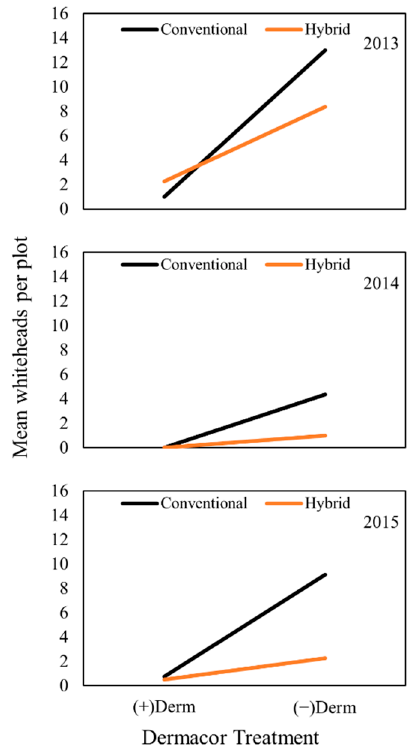
Figure A1. Interactive effects of Dermacor treatment and variety on L. oryzophilus larval densities in 2013, 2014, and 2015. Core 1 ( A , B, and C ) and Core 2 ( D , E, and F ) sampling were performed three and four weeks after permanent flooding. Parallel lines indicate absence of interaction ( P > 0.05), while lines with different slopes (non-parallel lines) indicate presence of interaction ( P < 0.05). Figure A,C,D,F show significant interactions.